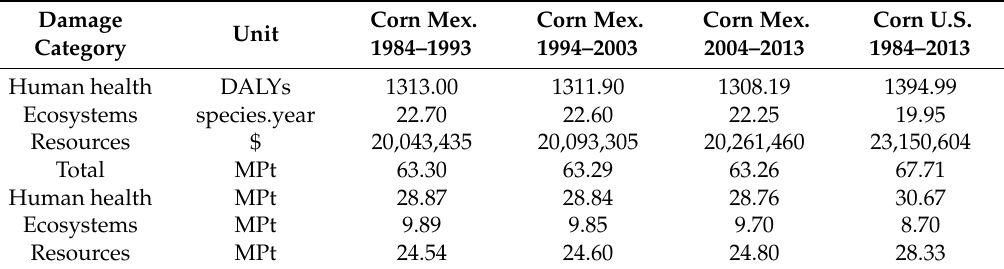
Table 4. Results by functional